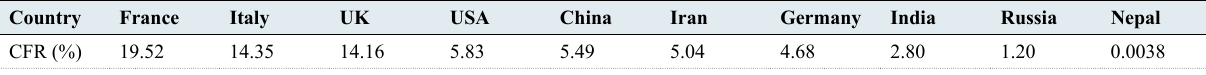
Table 2: The case fatality rate of COVID-19 in different countries by 3rd June